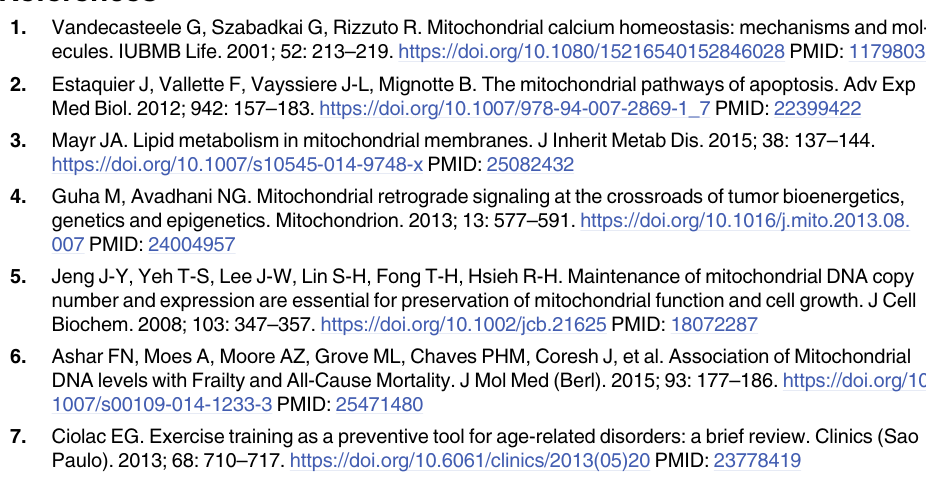
S2 Table. Adjusting for metabolic syndrome does not change results. Effect size estimates for secondary outcomes after including metabolic syndrome status as a covariate. Results gen- erally stay the same, indicating that metabolic syndrome is not mediating the effects of mtDNA-CN on these